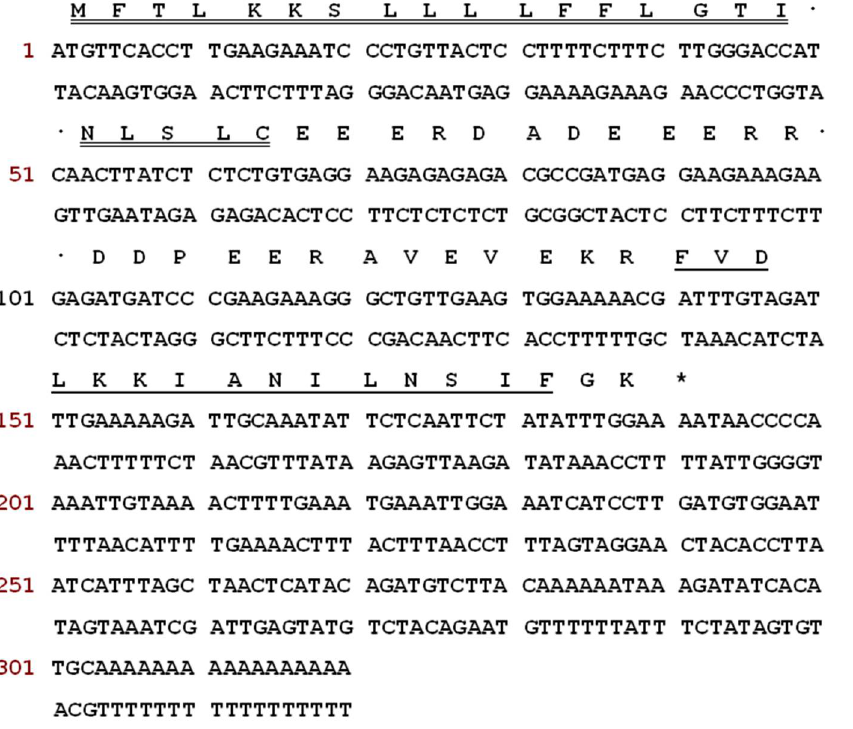
Figure 1. Nucleotide and ORF amino acid sequences of the precursor cDNA which was cloned from the skin secretion library of Rana chensinensis . Putative signal peptide sequence is double-underlined, mature peptide sequence is single-underlined and an asterisk represents the stop codon.